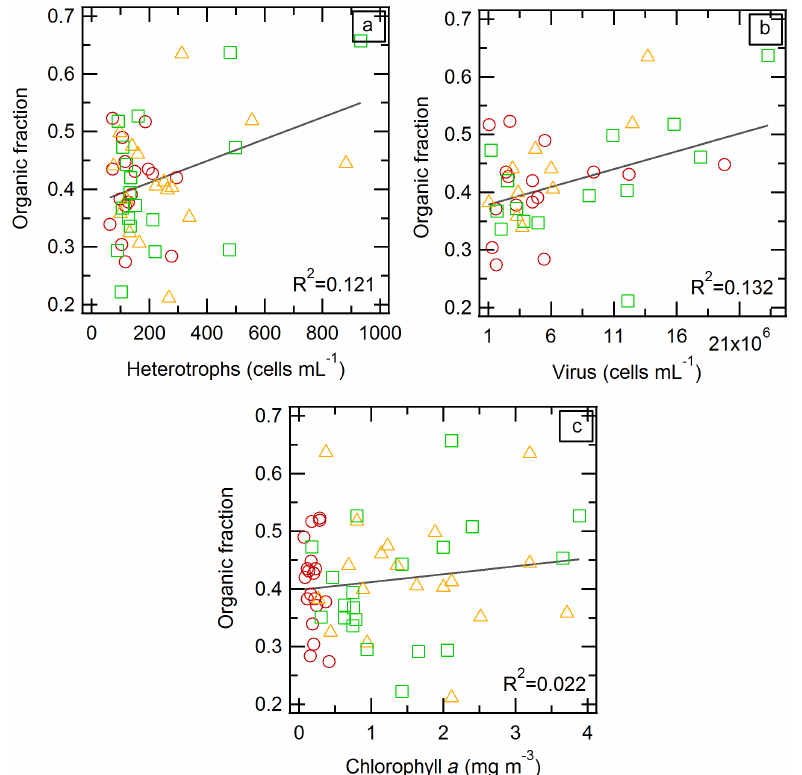
Figure 8. Correlation curves of the organic fraction from SS = 0.30% (representative for the Aitken mode particles) versus heterotrophic bac- teria abundance (a) , virus abundance (b) and chlorophyll a concentrations (c) with R 2 values of the fit from all three mesocosms combined. Data for mesocosm A (green squares), mesocosm B (yellow triangles) and mesocosm C (red circles) are